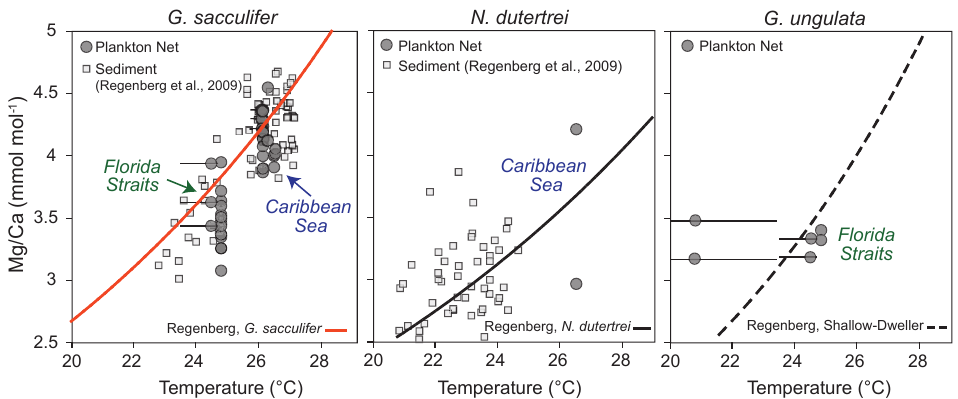
Figure 7. Mg / Ca values of ICP-OES bulk samples vs. temperature. Grey dots indicate the Mg / Ca values of living specimens ( G. sacculifer , N. dutertrei and G. ungulata ), depicted at the average in situ temperature of the plankton net (MSN) intervals in the Florida Straits and Caribbean Sea recorded during cruise M78/1. Black error bars indicate the modern temperature ranges of the sampling intervals. Grey squares indicate Mg / Ca ratios of fossil tests vs. δ 18 O calcification temperature from the Caribbean Sea and tropical Atlantic modified after Regenberg et al. (2009). Orange curve indicates the Mg / Ca calibration of Regenberg et al. (2009) (surface sediments) for G. sacculifer . The black curve indicates the Mg / Ca calibration of Regenberg et al. (2009) for N. dutertrei . The dashed black curve indicates the Mg / Ca calibration of Regenberg et al. (2009) for shallow